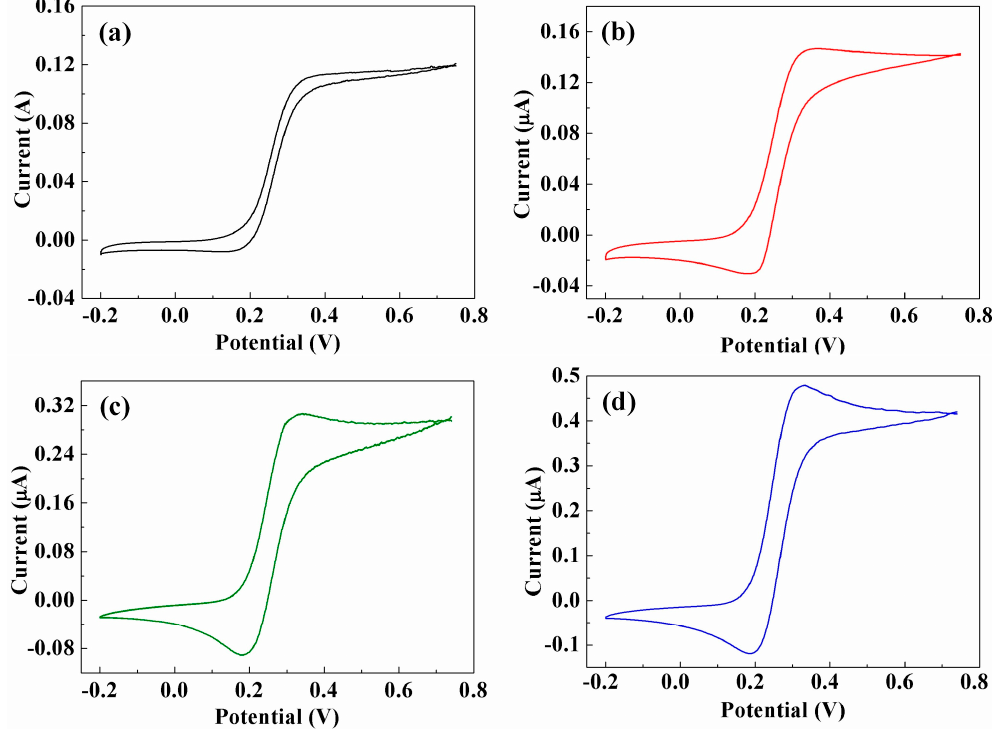
Figure 5. CV curves of ( a ) CFME-T0, ( b ) CNTs/CFME-T5, ( c ) CNTs/CFME-T10 and ( d ) CNTs/CFME-T15 in a 5.0 mM K 4 Fe(CN) 6 (in 1.0 M KCl) at a scan rate of 0.10 V·s − 1 .